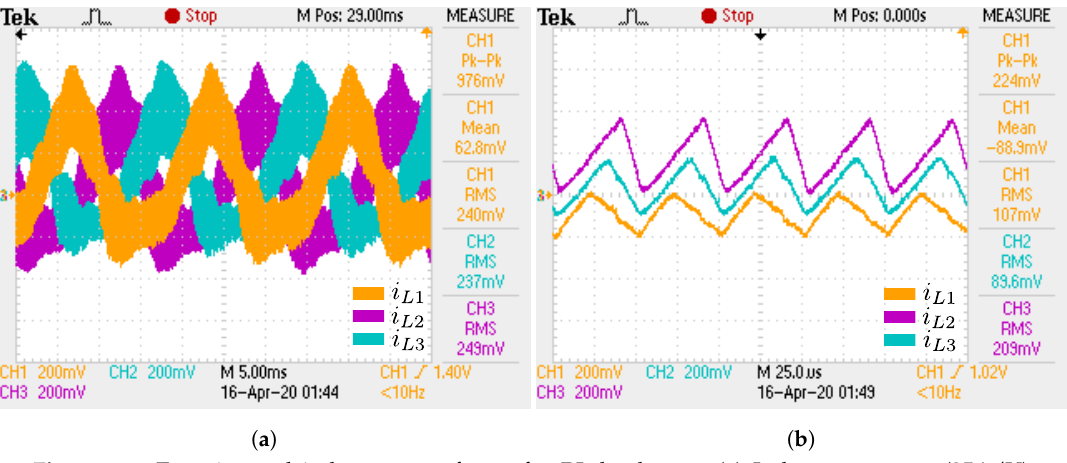
Figure 26. Experimental inductor waveforms for RL load case: ( a ) Inductor currents (25A/V);